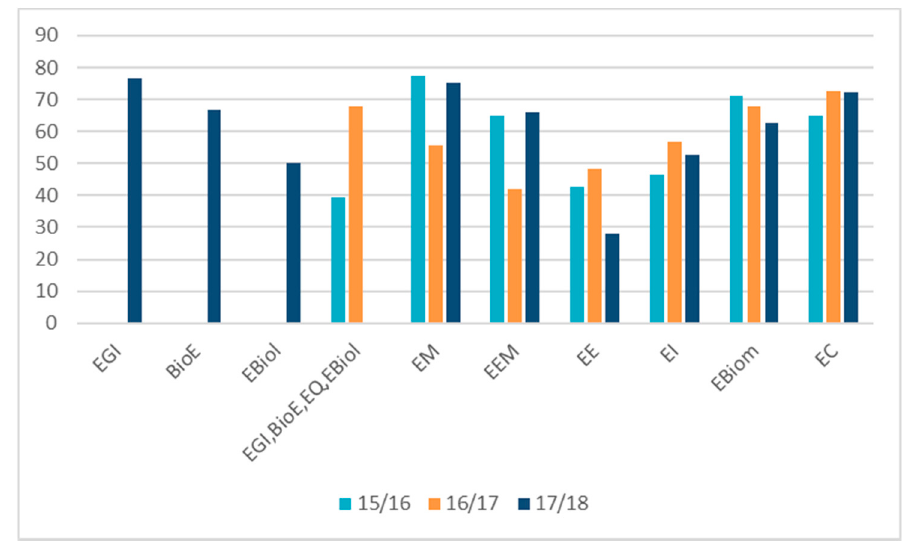
Figure 5. Pass rate distribution for the 1st semester of the academic years 2011/2012 to 2014/2015 and all undergraduate degrees in ISEC. Note that, in the academic year 2017/2018, the values corresponding to the EGI, Bi- oE, and EBiol degrees were only broken down and EQ ceased to be taught.